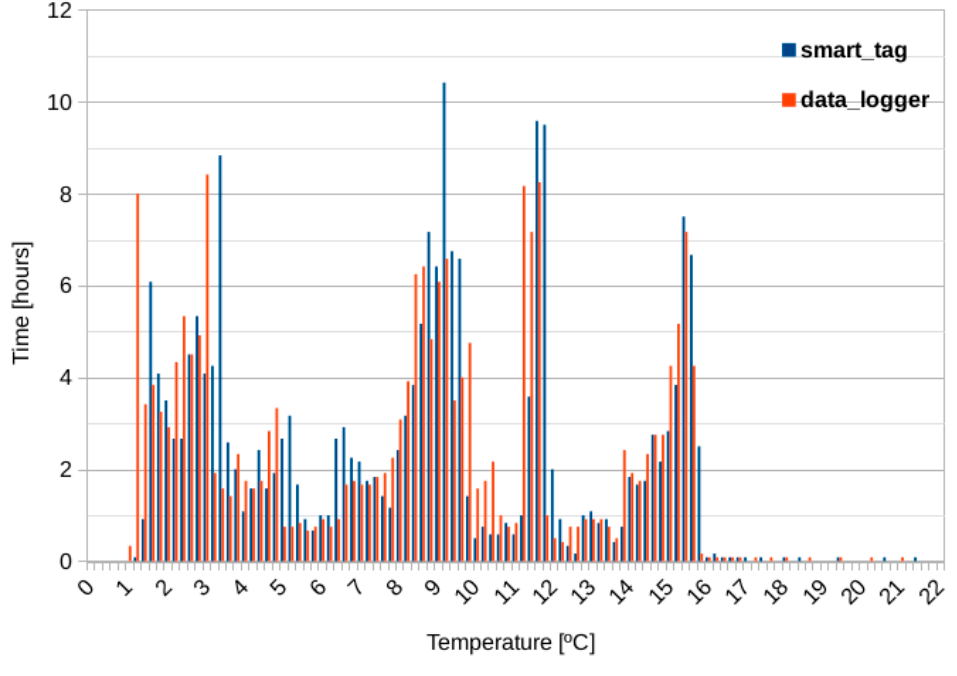
Figure 9. Orange temperature monitoring.